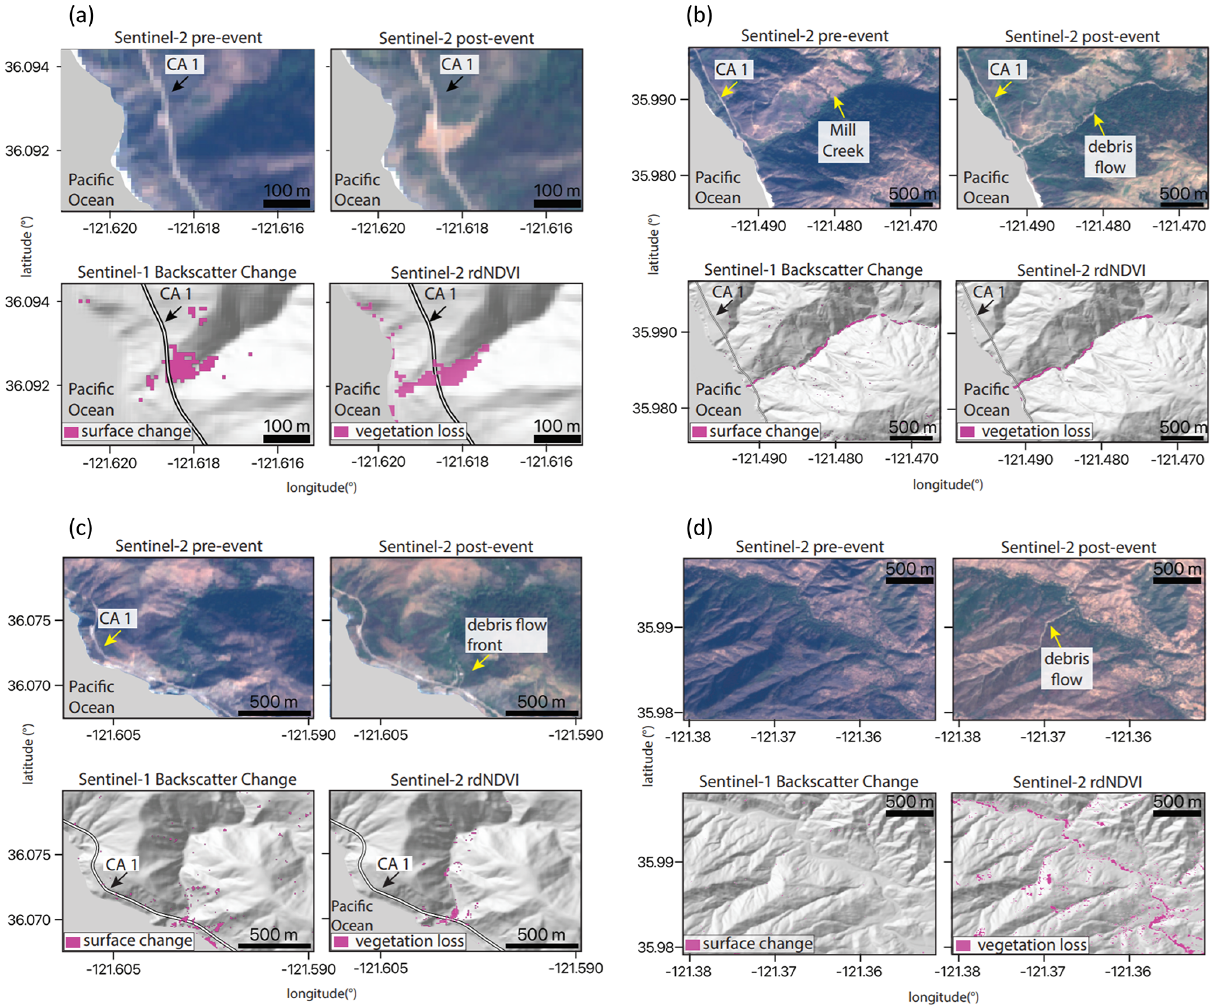
Figure B1. Optical- and SAR-based remote sensing data of four debris flows. Optical data from Sentinel-2 show pre- and post-debris flow imagery in real color; rdNDVI calculated from the Sentinel-2 data shows a decrease in vegetation corresponding to debris flow locations. Sentinel-1 backscatter change shows the change in ground surface properties determined by calculating the log ratio of pre- and post-event SAR images. The pre-event and post-event satellite images, Sentinel-1 backscatter, and Sentinel-2 rdNDVI change at (a) Rat Creek, (b) Mill Creek, (c) Big Creek, and (d)